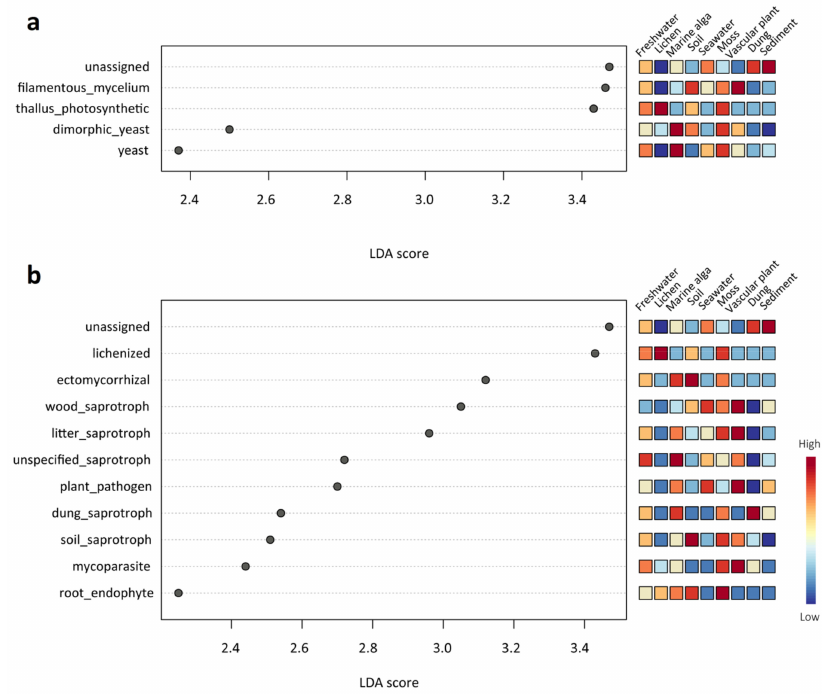
Figure 6. LEfSe analysis showing ( a ) the growth forms and ( b ) the functional guilds that differed significantly among the nine habitat types. The mini heatmap to the right of the plot indicates whether the taxa are higher (red) or lower (blue) in each